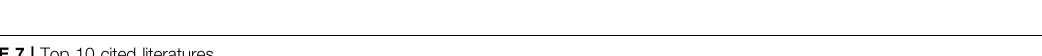
TABLE 7 | Top 10 cited